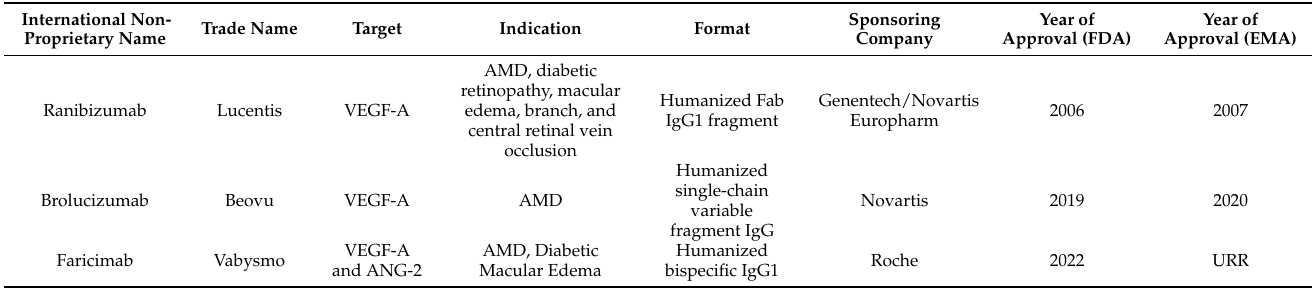
Table 4. Therapeutic antibodies approved by the Food and Drug Administration (FDA) and the European Medicine Agency (EMA) for intravitreal